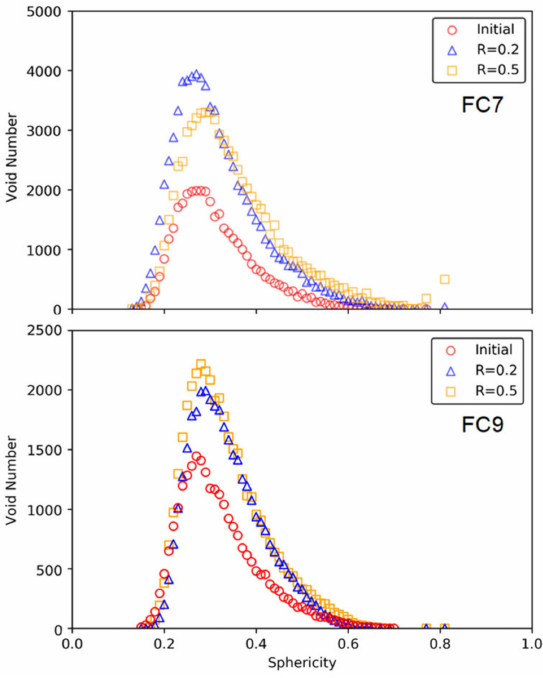
Figure 9. Change of void volume under plane strain cyclic compression